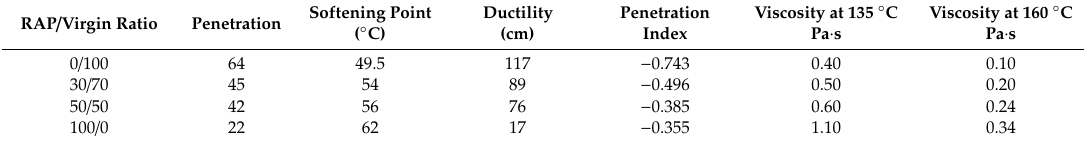
Table 4. Penetration, Softening Point, Ductility and Penetration Index for all the blends.